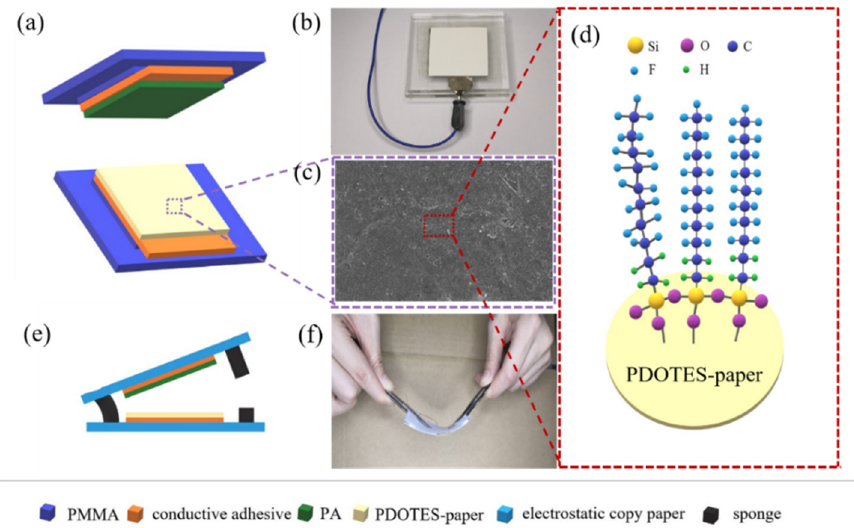
Figure 2. ( a ) Structural diagram of TENG; ( b ) TENG physical drawing; ( c ) SEM image of PDOTES- paper; ( d ) schematic diagram of TENG electrode; ( e ) diagram of wearable device structure; ( f ) physical drawing of wearable device.